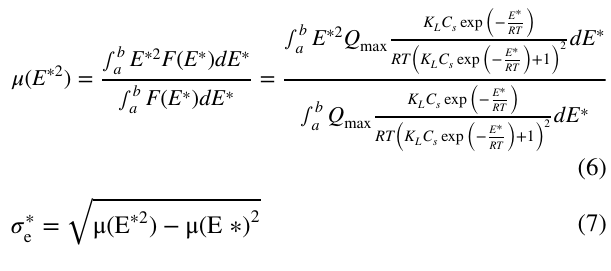
A16, 16-month aged sludge-derived hydrochars. A probability level of P < 0.05 (*) was used to indicate statistical significance, which is compared with control (278.15 K data in temperature effect and CK data in cation